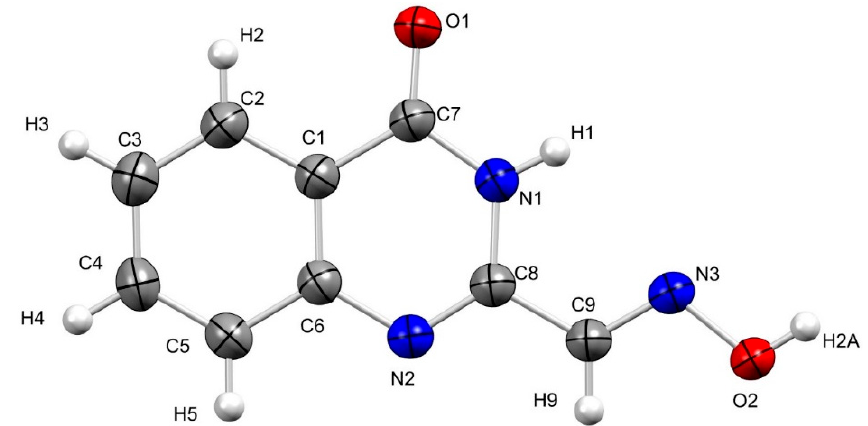
Figure 2. Geometry of ( E )-4-oxo-3,4-dihydroquinazoline-2-carbaldehyde oxime ( 8 ) in the crystal; crystallographic atom numbering. Thermal ellipsoids at 50% probability.